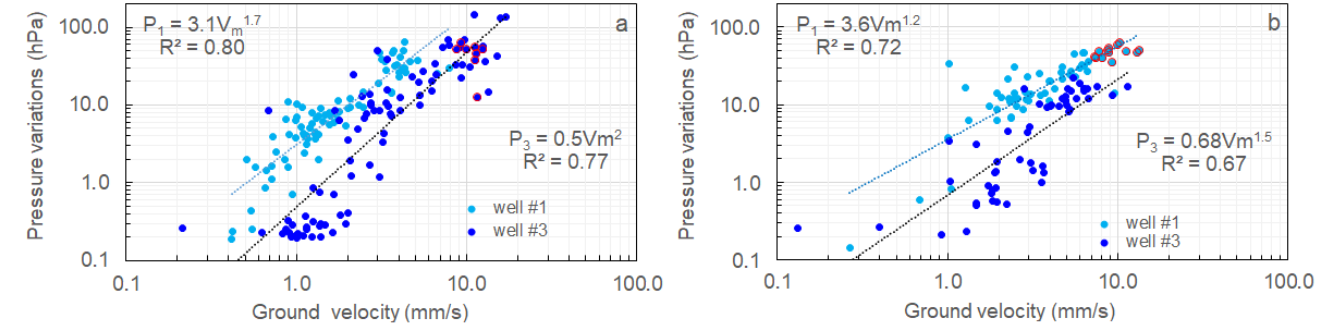
Figure 5. Pore pressure variations in the system “reservoir–well” versus ground velocity for explosions in the mine ( a ) and in the quarry ( b ) (red circles denote explosions after which postseismic lowering of water level was traced).